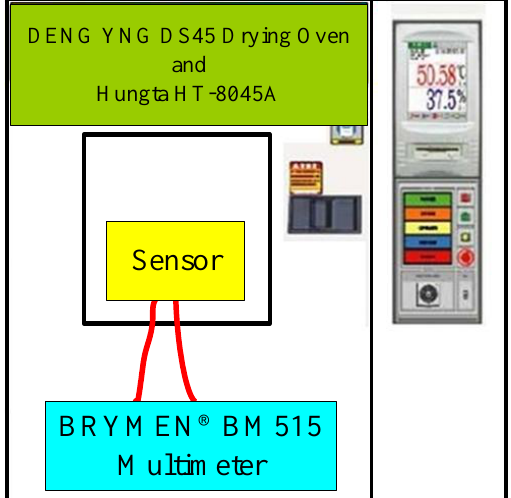
Figure 4. Programmable temperature calibration